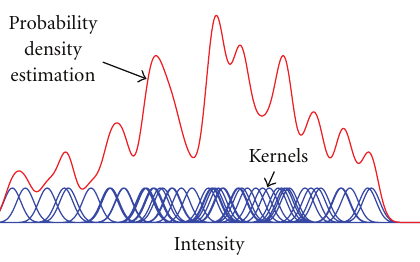
Figure 4: Illustration of Parzen windowing method for estimating density probability of image